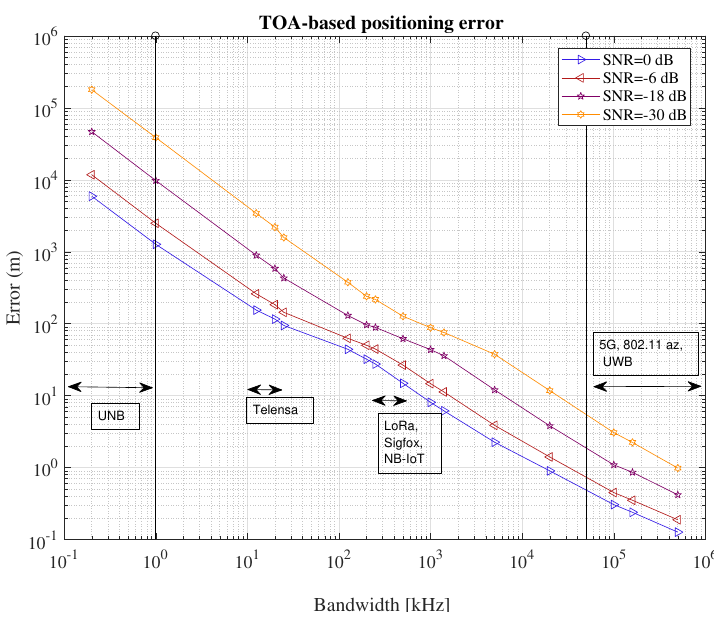
Figure 3. Comparative analysis of TOA-based position estimates at various